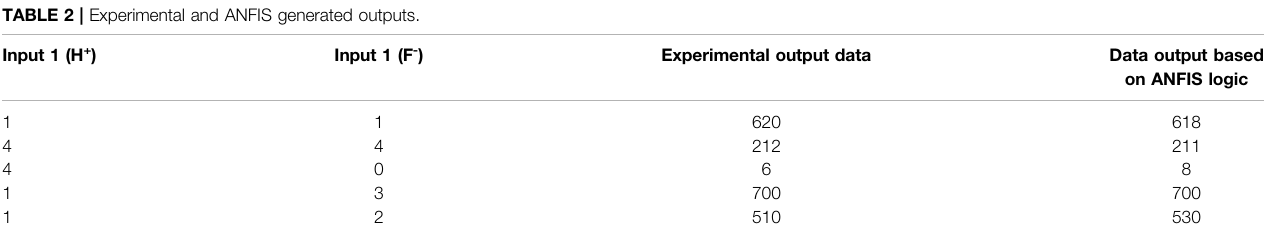
TABLE 2 | Experimental and ANFIS generated